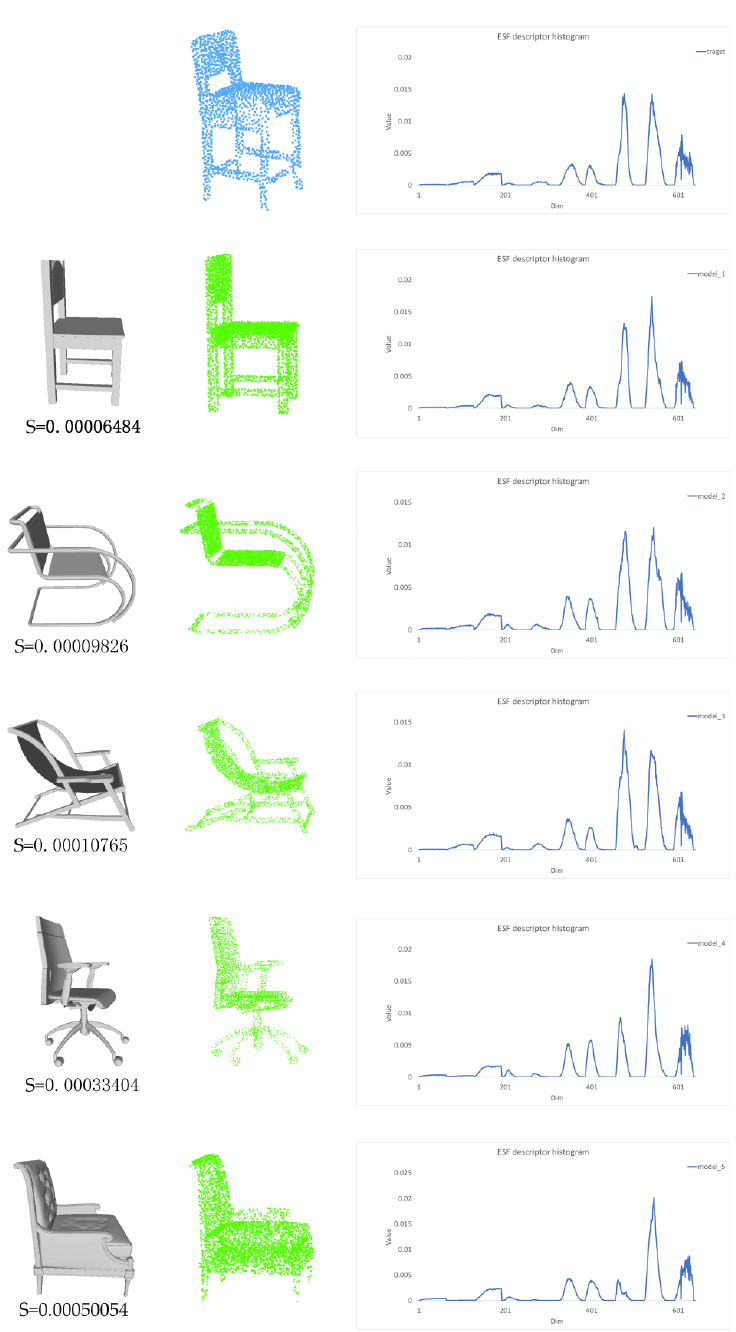
Figure 12. The first row (blue) is the target point cloud (sampling density is 0.02 m) and its ESF- descriptor histogram. The remaining rows are 5 candidate chair models, sampled point clouds and the ESF-descriptor histogram. The rows are sorted by the similarity distance S from target point cloud (lower is better).